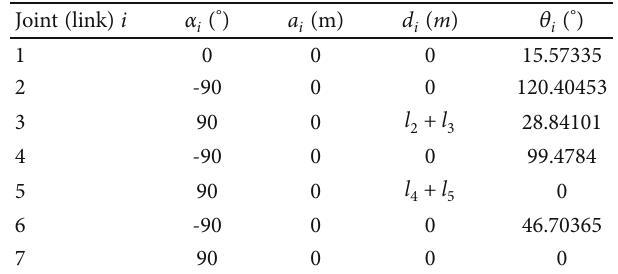
Figure 4: De fi nition of joints and links of the 7-DOF manipulator. Table 2: D – H parameters of the 7-DOF